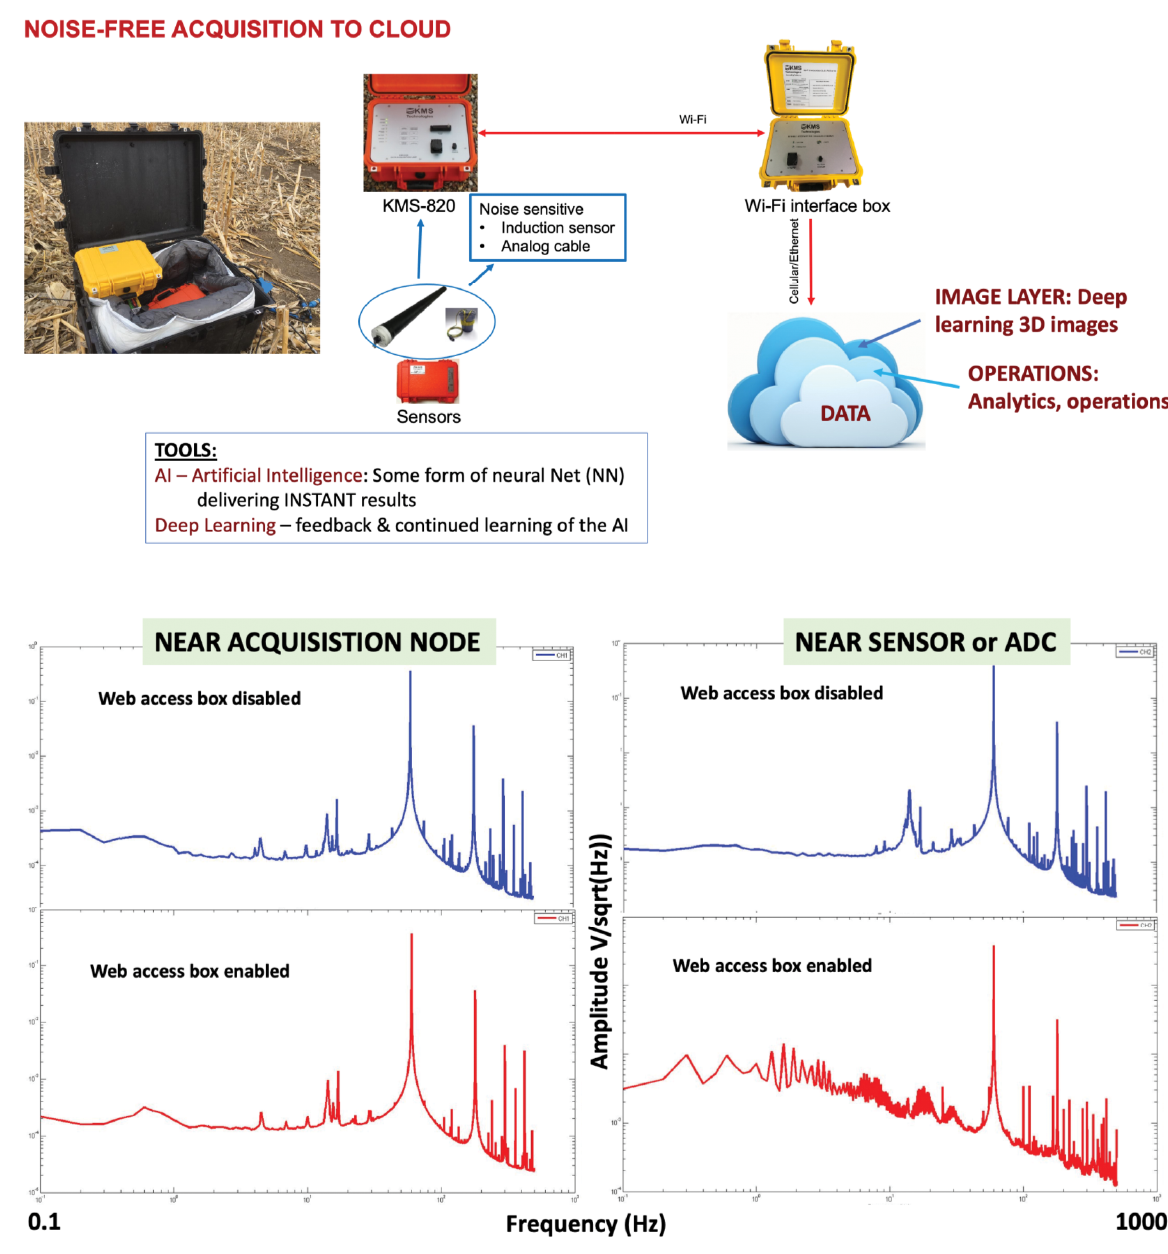
Figure 10. Process flow of electromagnetic data directly to the Cloud ( top half ) and a data example illustration of the noise improvement using a noise-free web access box ( bottom half ). On the top left is the acquisition system with the web access box (yellow box) that is placed away (20 m) from the sensitive magnetic field sensor displayed in the pictorial flow diagram below the acquisition unit. From the web access box (Wi-Fi interface in the figure) the data are sent to the Cloud via cell phone, and wireless connection or wired local area network (LAN). The plots below show the frequency spectra of data recording with and without web access box and close to the magnetic field sensor ( right side ) versus away from the sensor.